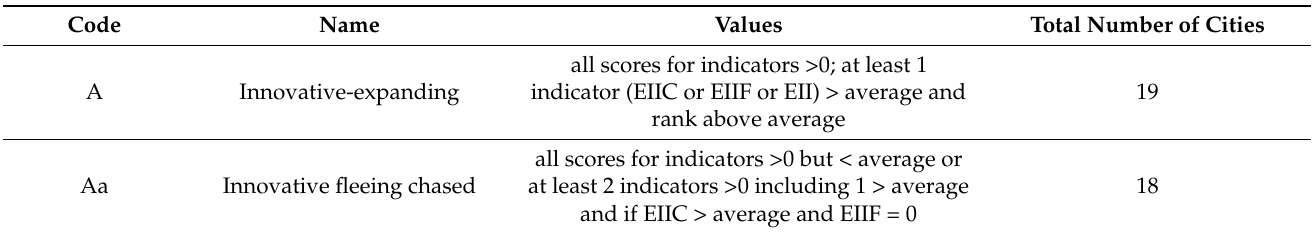
Table 5. Criteria for ranking cities according to innovation in 2nd generation